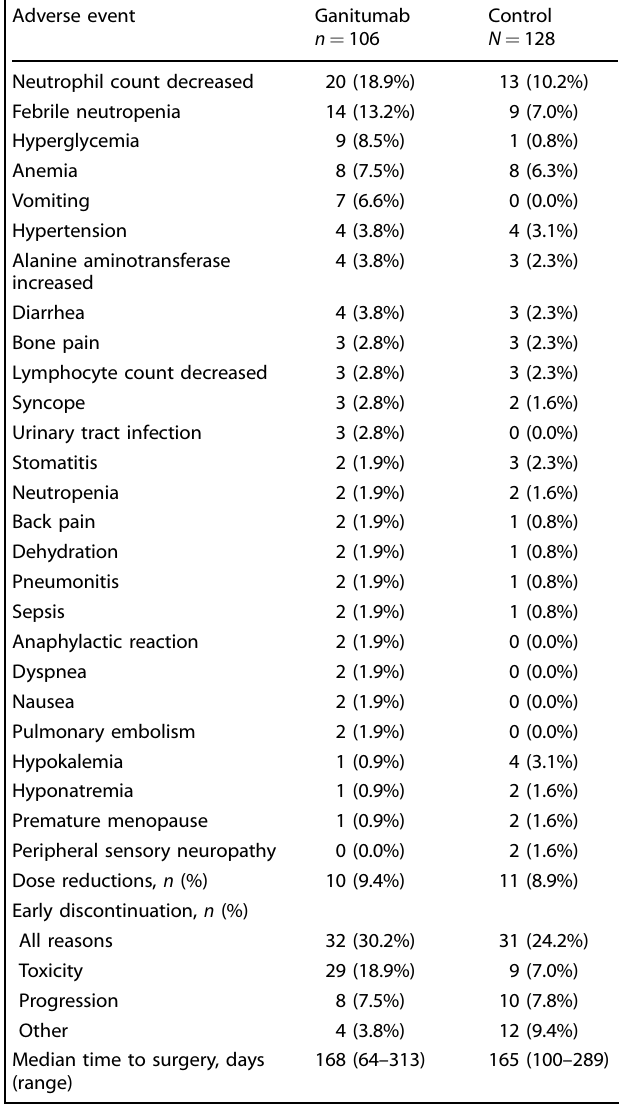
Table 3. Grade 3 – 4 adverse events experienced by greater than 1% of participants in either the ganitumab + metformin or control